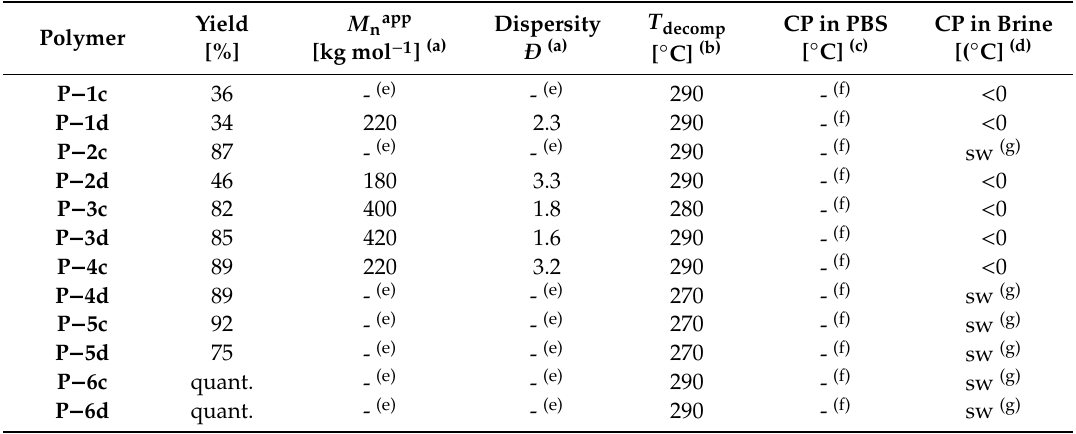
Table 2. Molar masses of the homopolymers prepared, and their solubility (3 wt %) in various aqueous